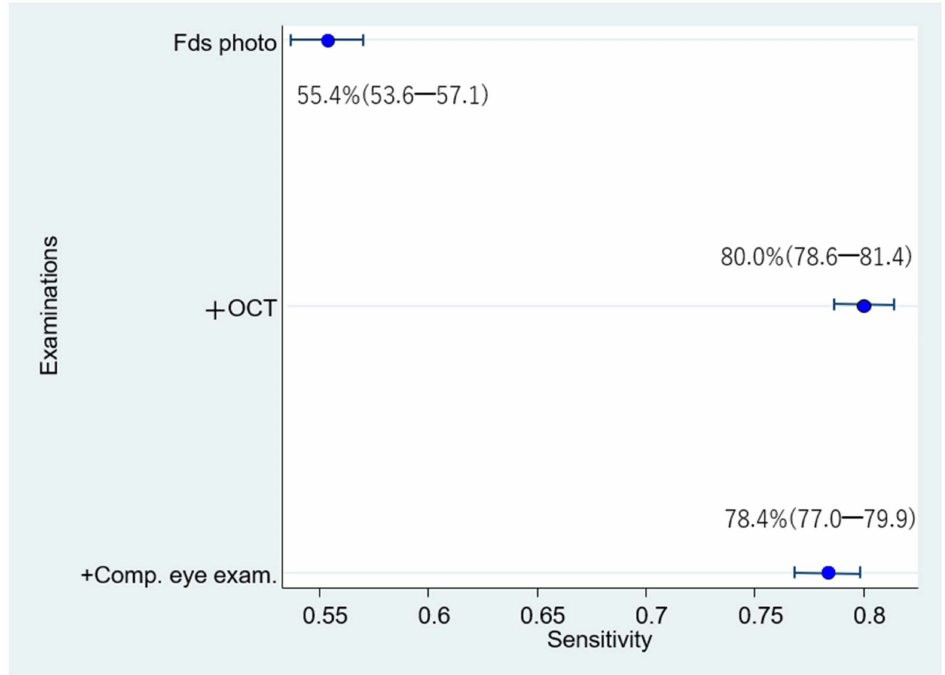
Figure 5. Sensitivity for diagnosis by 24